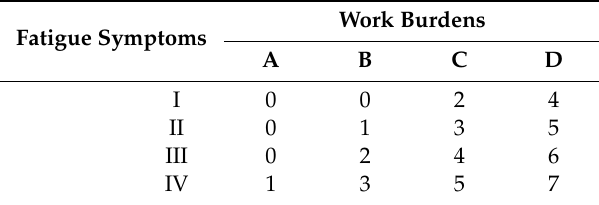
Table 2. Scale matrix concerning fatigue symptoms and work